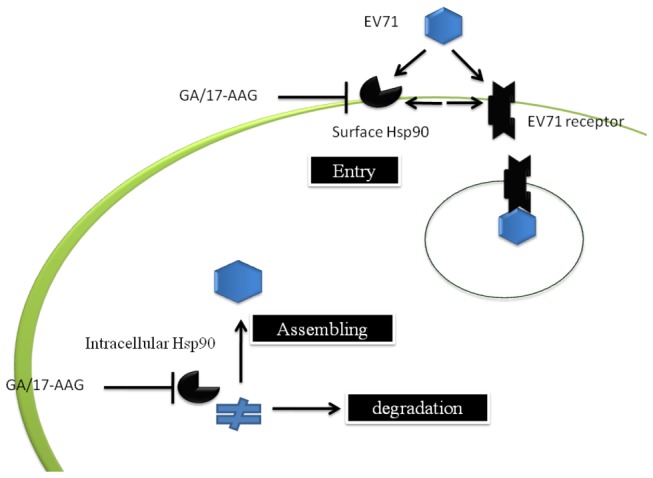
Model illustrating how HSP90 interacted with EV71 and supported EV71 infection.In the infection, EV71 particles attach to the surface receptors (such as human SCARB2 or PSGL-1), HSP90 expressed on the surface may following bind to EV71 and help for virus entry. The newly synthesized viral capsid proteins may bind to HSP90 to avoid being degraded by proteosome that facilitates viral assembling. Targeting of HSP90 using the inhibitor geldanamycin (GA) and its analog, 17-allyamino-17-demethoxygeldanamycin (17-AAG), can efficiently control EV71 infection based on the blockage the described pathways that HSP90 involved.